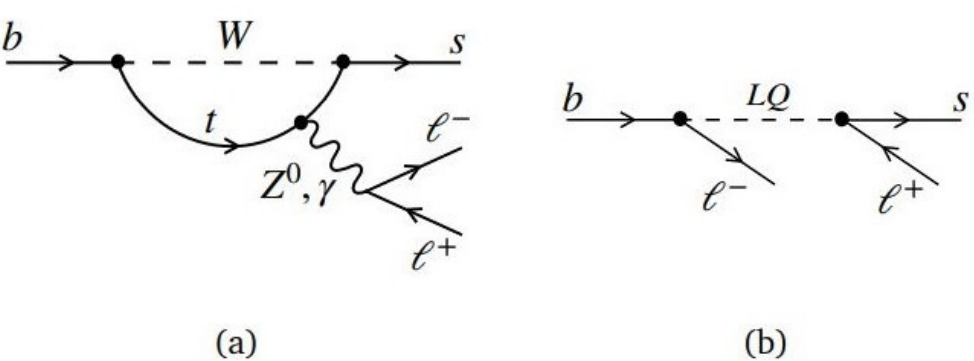
Figure 1. ( a ) SM contribution for b → sl + l − transition including W, Z, and γ via loop level. ( b ) NP contribution involving a leptoquark (LQ coupling directly to quarks and leptons)